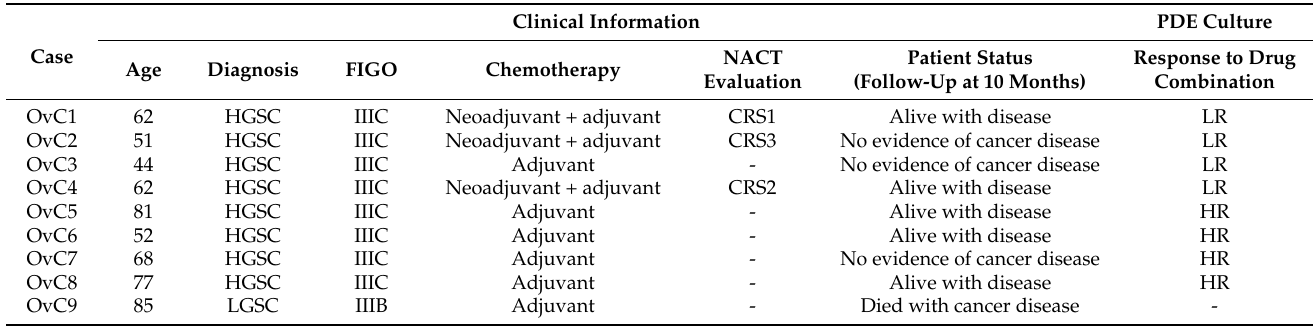
Table 1. Ovarian Carcinoma patient cohort: clinical data and patient-derived explant (PDE) culture